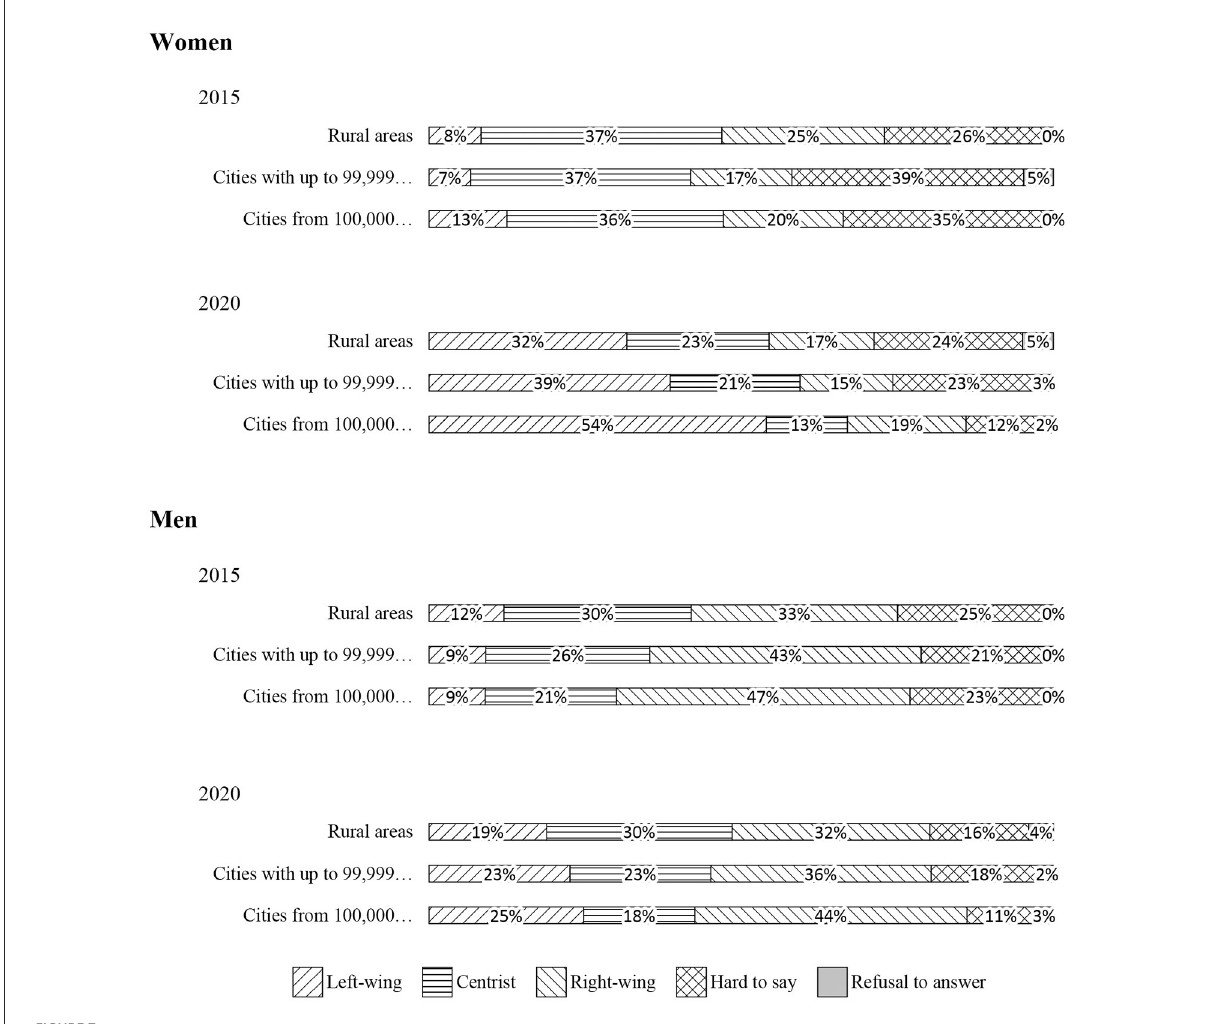
FIGURE7 Declared political views of respondents aged 18–24 by gender and place of